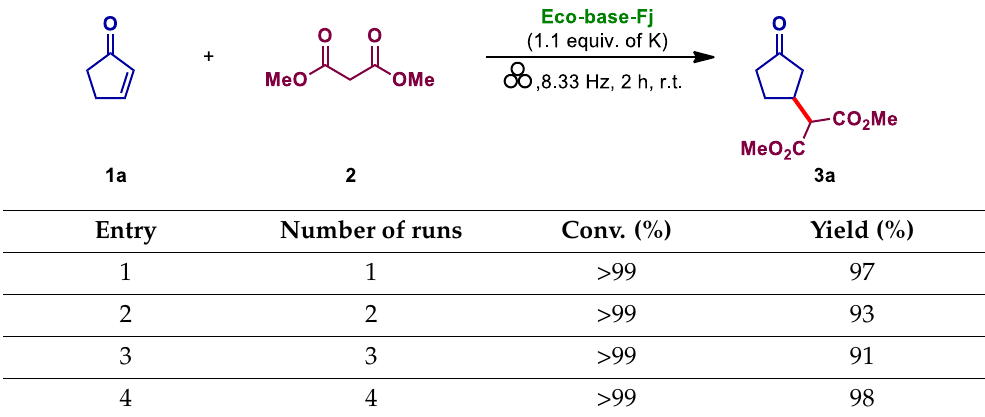
Table 5. Recyclability of Eco-base-Fj.